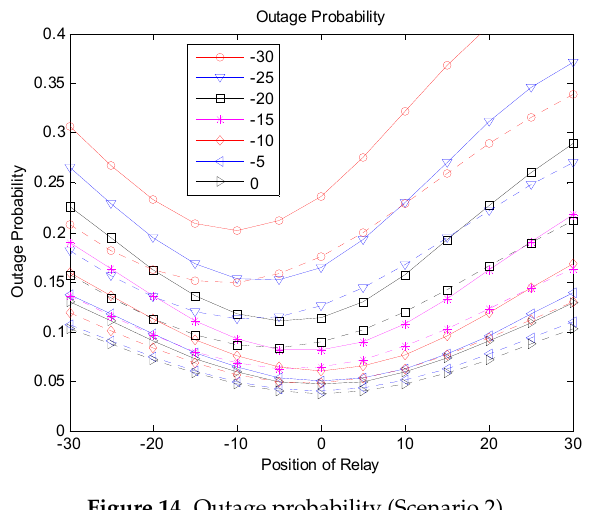
Sensors 2018 , 18 , x FOR PEER REVIEW Figure 14. Outage probability (Scenario 2). Figure 14. Outage probability (Scenario 2). Figure 14. Outage probability (Scenario 2).